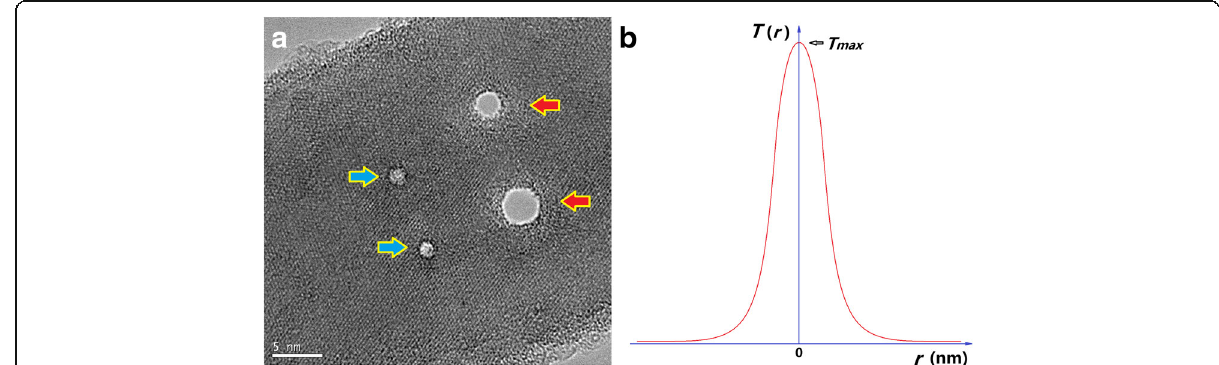
Fig. 5 Distribution of local temperature under irradiation of a nanoscale e-beam. a A single crystalline Si NW with four nano-holes drilled with a HIEB in TEM. Two shallow holes are highlighted with blue arrows, and two through holes are highlighted with red arrows. b Estimated T ( r ) function for the local temperature versus distance to the central